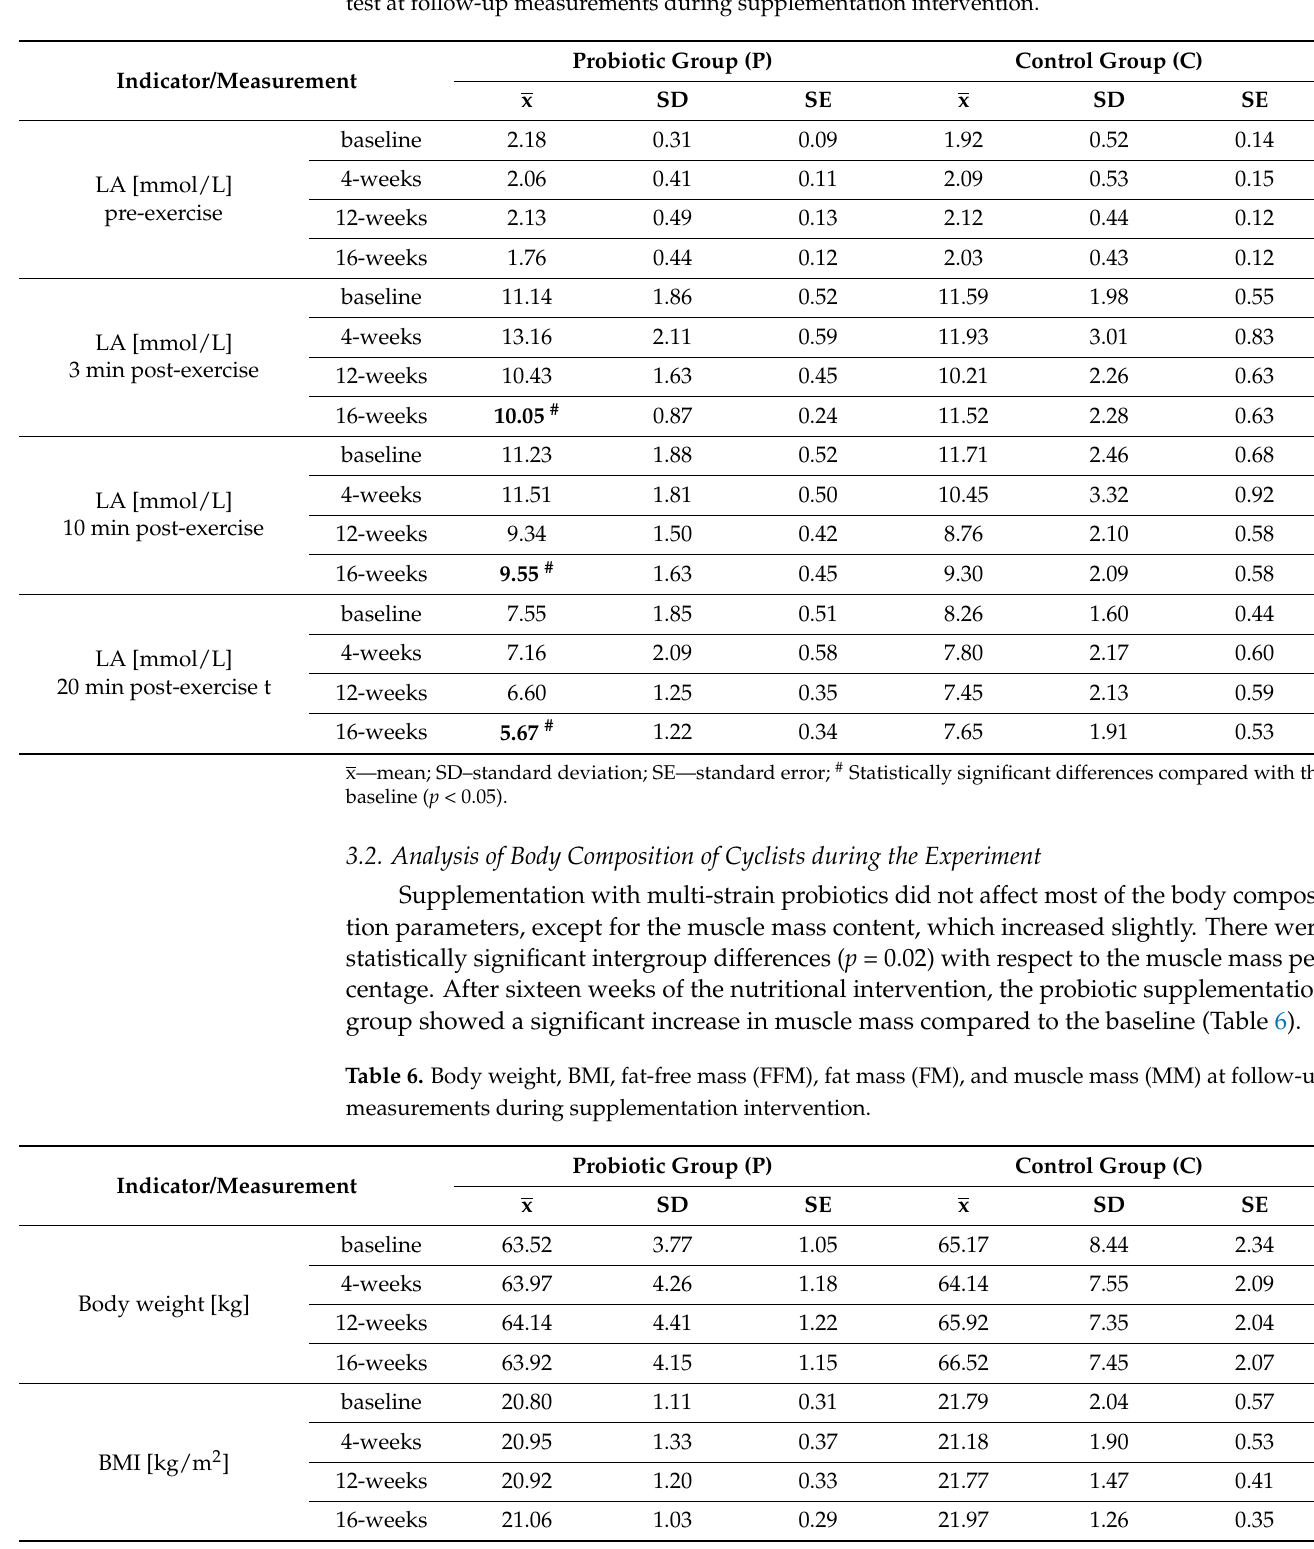
Table 5. The blood lactate concentrations at baseline, 3, 10, and 20 min post-exercise for the anaerobic test at follow-up measurements during supplementation intervention.